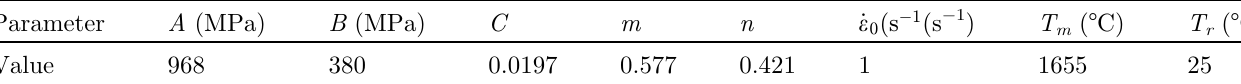
Table 2. Parameters of Johnson-Cook model for TC4 titanium alloy.